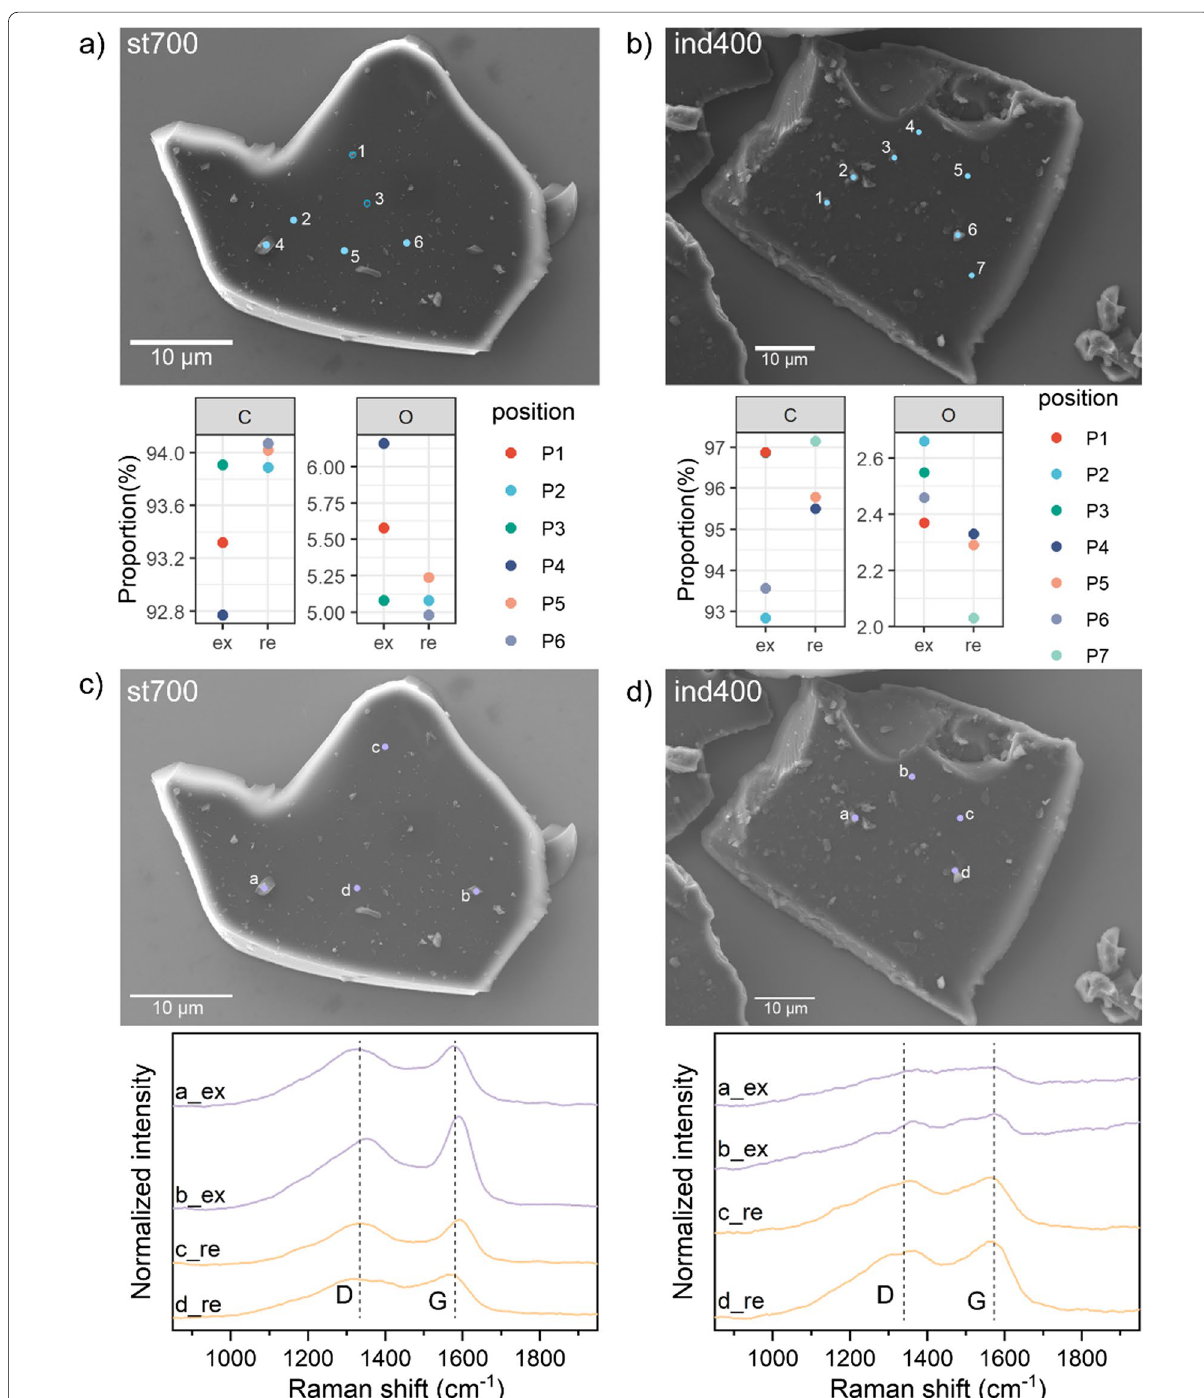
Fig. 4 SEM images, elemental proportion by EDS, and Raman spectra of nanoparticles and residual chars. Elemental compositions of a st700 and b ind400. Raman spectra of c st700 and d ind400. The tested spots were marked by the dots and labeled by numbers/letters in the corresponding SEM images. “st” and “ind” represent chars derived from starch and indigo dye, respectively. The suffix number represents pyrolysis temperature. “ex” and “re” stand for nanoparticles and residual chars,